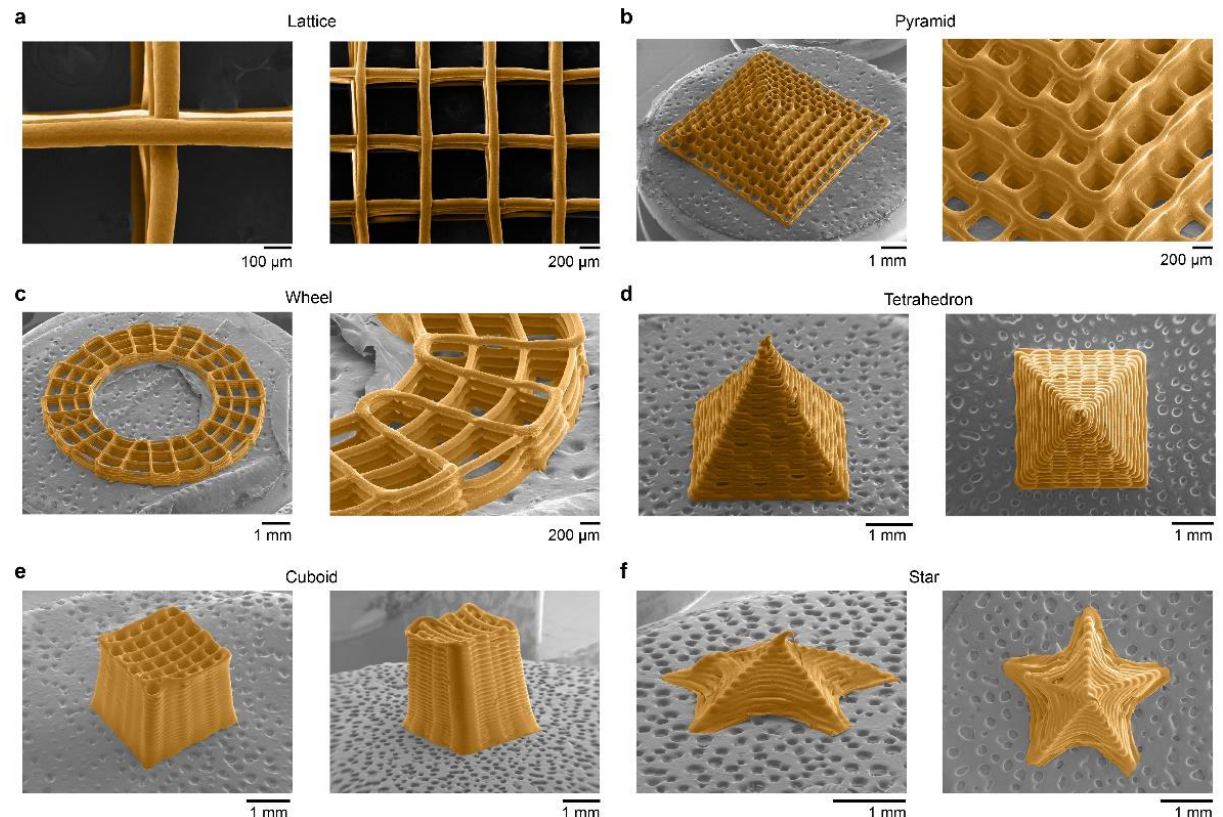
Figure 3. SEM characterizations of representative 3D silk fibroin prints. SEM images of ( a ) the 3D lattices, highlighting single filaments and connections between filaments. ( b ) A 32-layer pyramid-like 3D print. ( c ) An 8-layered wheel-like 3D print. ( d ) A 40-layer tetrahedron-like 3D print. ( e ) A 40-layer cuboid 3D print. ( f ) A single-layer star-like 3D print. Silk fibroin materials are displayed in orange in all SEM images.